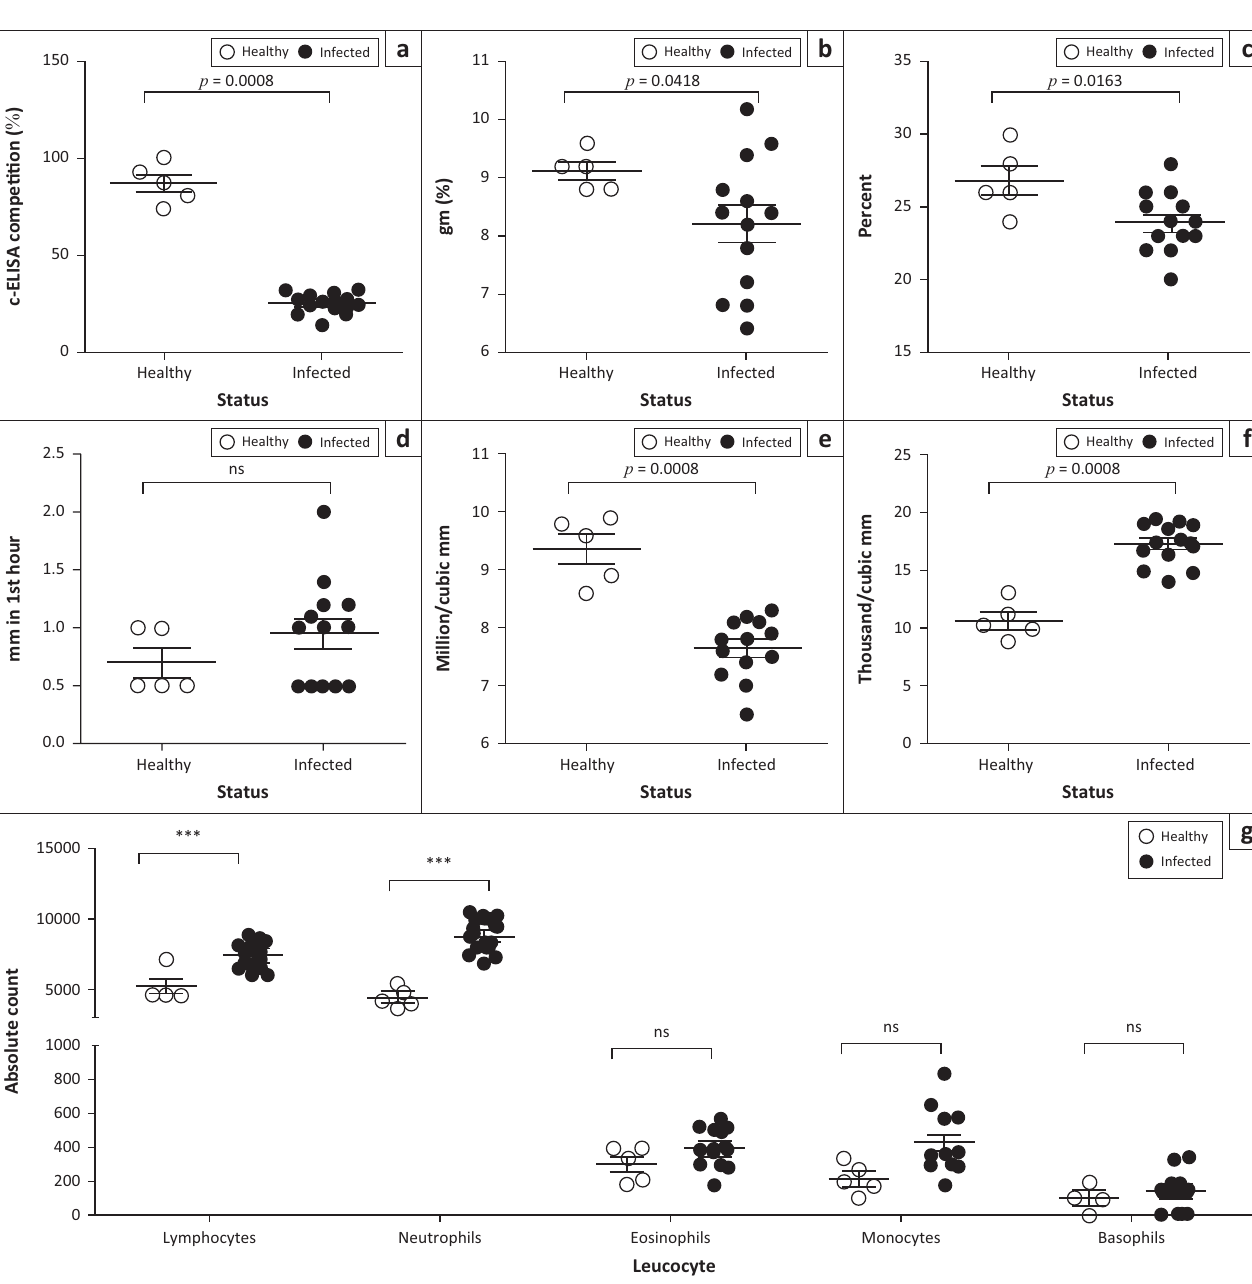
FIGURE 3: Haematological profile of peste des petits ruminants virus–infected Black Bengal goats showed marked anaemia and leucocytosis. Blood samples were collected from healthy and peste des petits ruminants –affected goats and the amount of (a) peste des petits ruminants virus–specific antibody, (b) haemoglobin, (c) packed cell volume, (d) erythrocyte sedimentation rate, (e) total erythrocyte counts, (f) leucocyte count and (g) differential leucocyte count were quantified. Data indicate mean ± SEM from 5 healthy and 13 peste des petits ruminants virus–infected goats. One-tailed Mann–Whitney test. p ≤ 0.05 was considered statistically